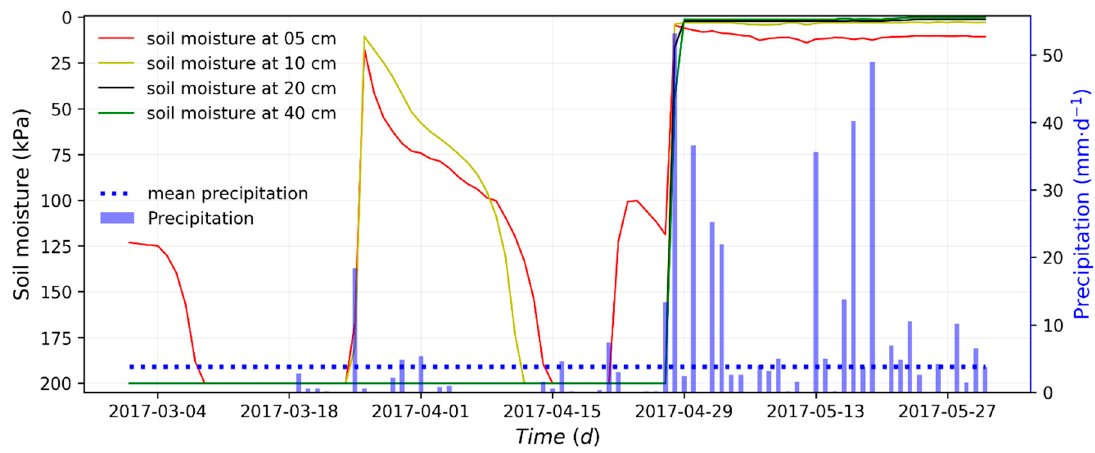
Figure 11. Observed soil moisture tension (kPa) at 5, 10, 20, and 40 cm soil depth (left y -axis) and daily precipitation (mm · d − 1 ; bar plot for observed and dot plot for average precipitation distribution) (right y -axis) at the Tegecha (2140 m) station from March to May in 2017. The soil moisture tension is represented by daily averages (line plots). Note that 0 kPa means the soil is fully saturated and 200 kPa means fully dry soil.